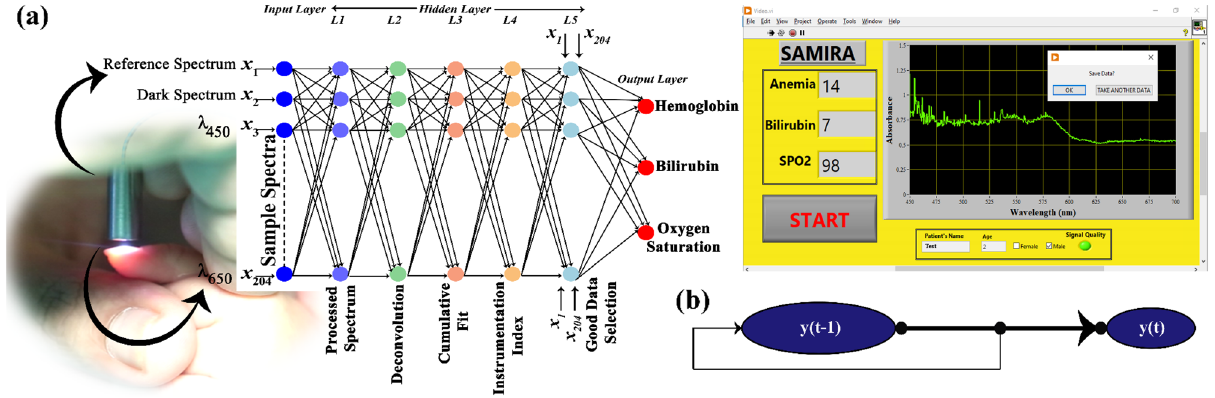
Figure 2. Machine Learning Algorithm ( a ) Schematic representation of ANN used in the proposed device for the detection of Hemoglobin, Bilirubin and Oxygen Saturation ( b ) Time dependent continuous series flow diagram to estimate the blood parameters in regular time intervals (see